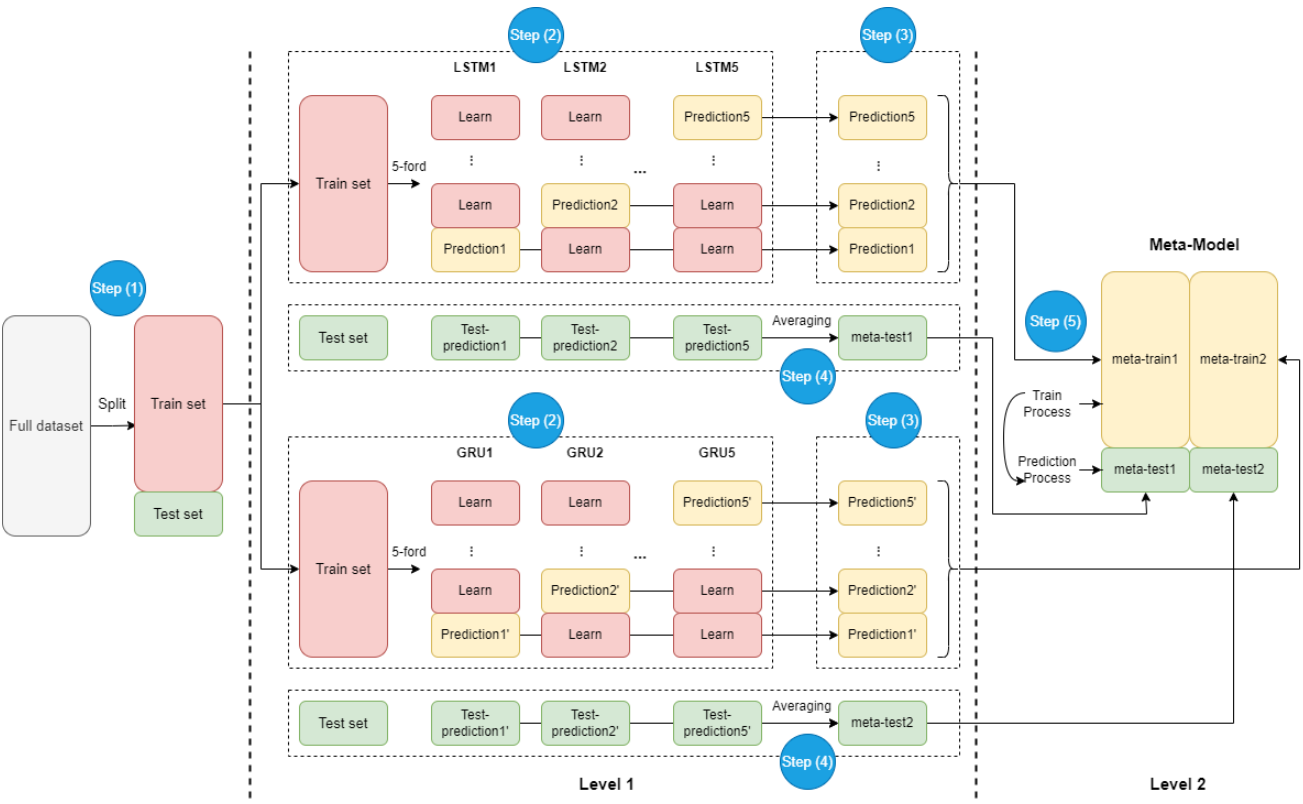
Figure 6. Stacking ensemble